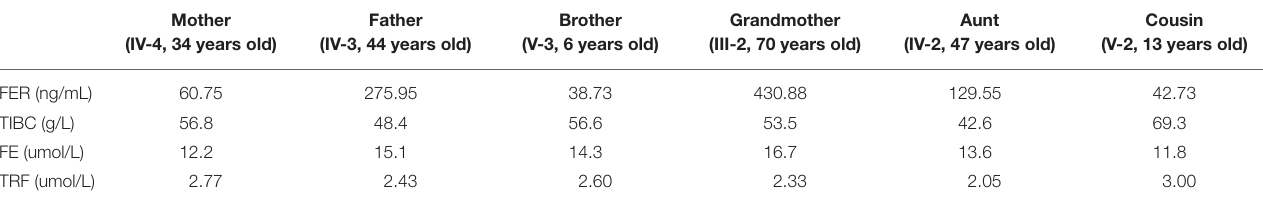
TABLE 1 | Blood examination of members in the pedigree detecting